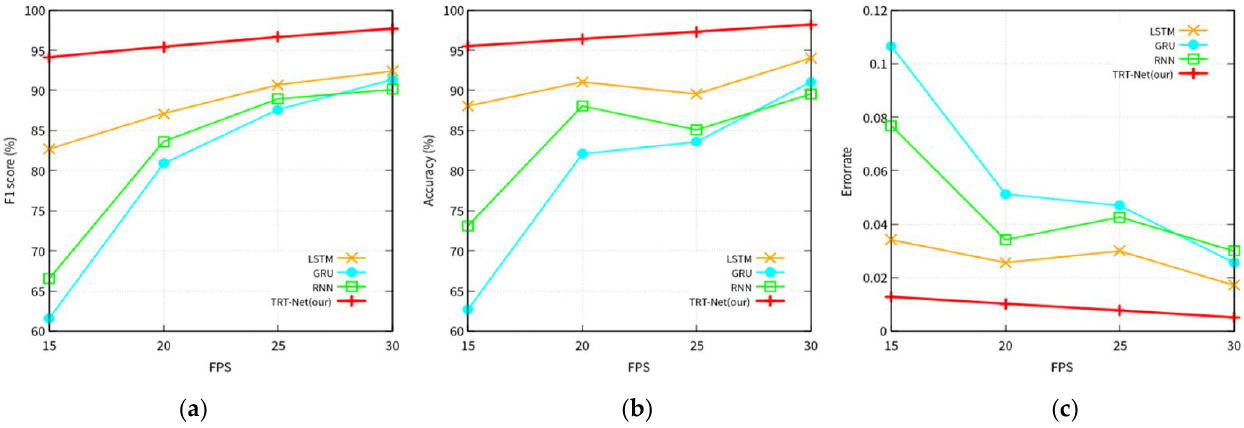
Figure 8. Graphs showing ( a ) F1 score, ( b ) accuracy, and ( c ) error rate of four models (LSTM, GRU, RNN, TRT-Net